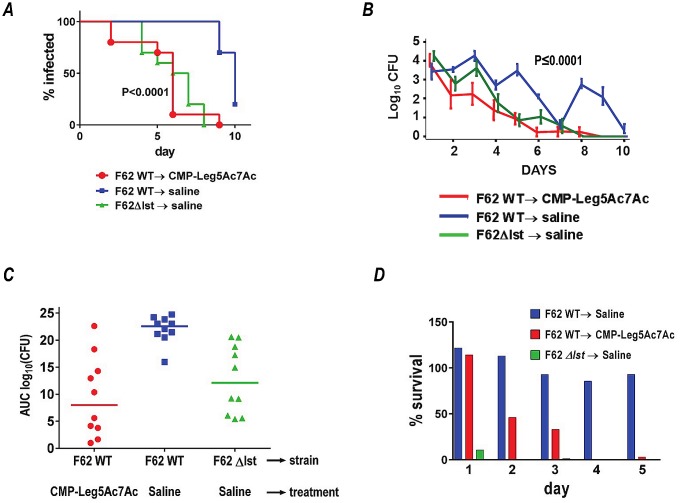
CMP-Leg5Ac7Ac treatment reduces the duration of infection and the burden of N. gonorrhoeae (Ng) F62 in the BALB/c mouse vaginal colonization model.Three groups of 17β-estradiol treated BALB/c mice (n = 10/group) were inoculated and treated as follows: i) wild-type F62; saline (vehicle control), ii) wild-type Ng F62; treated with CMP-Leg5Ac7Ac 10 μg/ml intravaginally daily and iii) Ng F62 Δlst; saline. Vaginal swabs were obtained daily to quantify Ng CFUs. A. Kaplan Meier analysis of time to clearance. B. Colonization of bacteria (log10 CFU) measured daily. C. Bacterial burdens consolidated over time (Area Under the Curve [log 10 CFU] analysis) for the three groups. There were no statistically significant differences noted between the group treated with CMP-Leg5Ac7Ac and the Ng F62 Δlst group. D. Complement resistance of Ng recovered directly from the genital tract of mice simulates findings in vitro. Equal volumes of vaginal secretions from all mice within a group on each day were pooled, serially diluted and incubated with 10% NHS. Survival of bacteria at 30 min relative to 0 min was measured and the percentage survival expressed on the Y-axis.